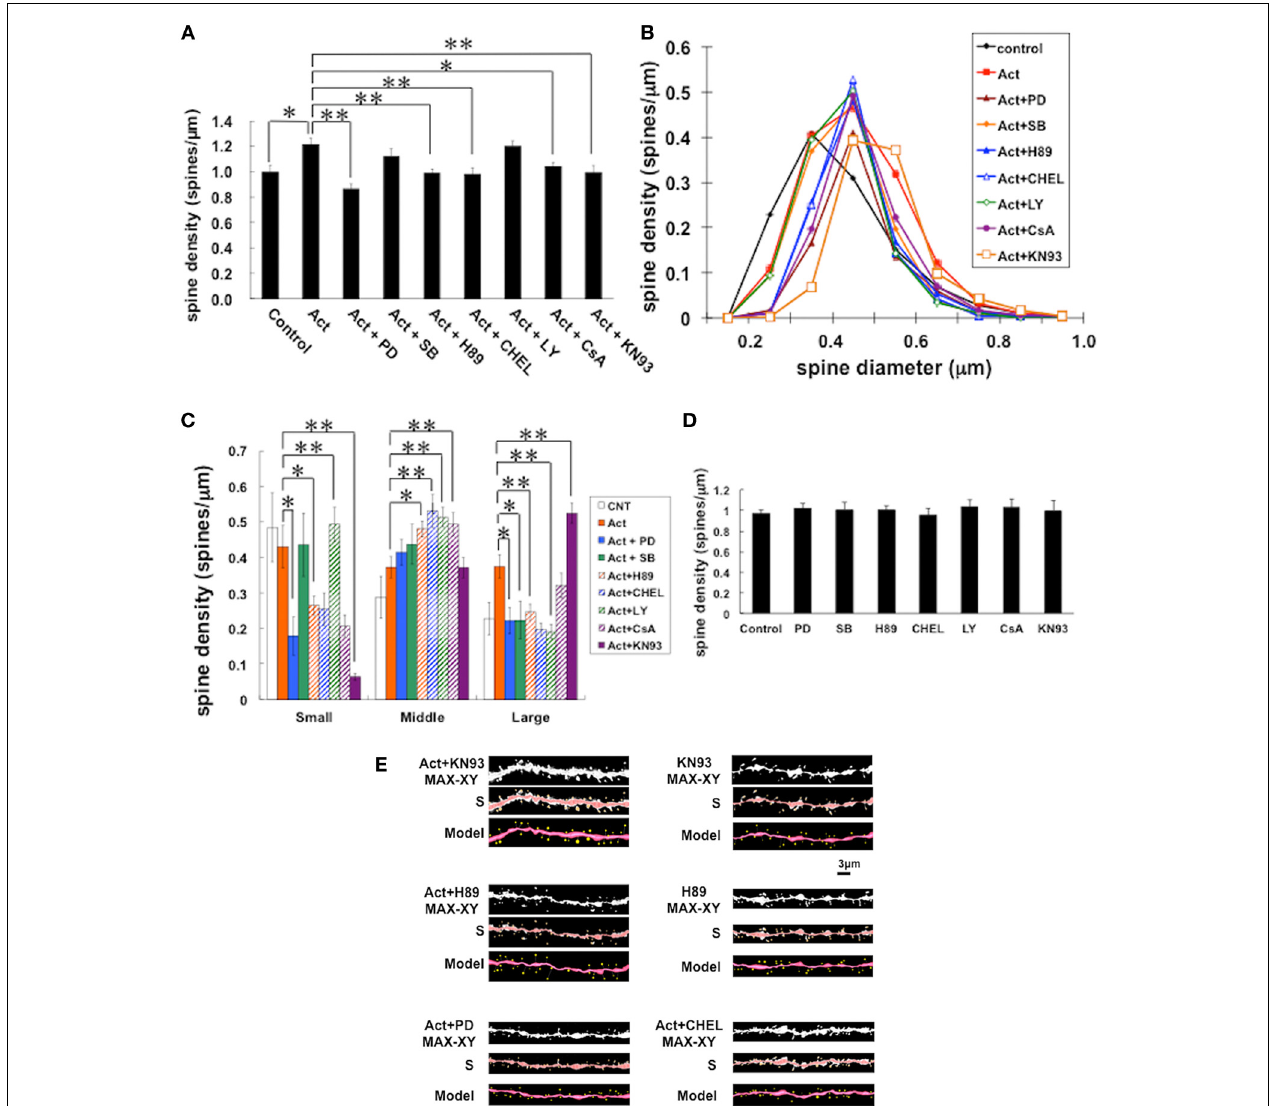
FIGURE 4 | Effects by inhibition of kinases on changes of the density and morphology of spines in the presence of activin A. Spines were analyzed along the secondary dendrites of CA1 pyramidal neurons. (A) Total spine density. Effect of kinase inhibitors in the presence of activin in CA1 neurons. Vertical axis is the average number of spines per 1 μ m. A 2-h treatment in ACSF without drugs (Control), with 10ng/mL activin (Act), with 10ng/mL activin and 20 μ M PD98059 (Erk MAPK inhibitor) (Act + PD), with 10ng/mL activin and 10 μ M SB203580 (p38 MAPK inhibitor) (Act + SB), with 10ng/mL activin and 10 μ M H-89 (PKA inhibitor) (Act + H89), with 10ng/mL activin and 10 μ M chelerythrine (PKC inhibitor) (Act + CHEL), with 10ng/mL activin A and 10 μ M LY294002 (PI3K inhibitor) (Act + LY), with 10ng/mL activin and 1 μ M cyclosporin A (calcineurin inhibitor) (Act + CsA), and with 10ng/mL activin and 1 μ M KN-93 (CaMKII inhibitor) (Act + KN93). Statistical significance is calculated against activin treated group and indicated by stars. ∗ P < 0 . 05, ∗∗ P < 0 . 01. (B) Histogram of spine head diameters. Abbreviations are the same as in (A) . Vertical axis is the number of spines per 1 μ m of dendrite. After a 2-h treatment in ACSF without drugs (Control, closed black diamond), Act (closed red square), Act + PD (closed brown triangle), Act + SB (closed orange diamond), with Act + H89 (closed blue triangle), with Act + CHEL (open blue triangle), with Act + LY (open green diamond), and Act + CsA (closed purple circle), and Act + KN93 (open orange square). (C) Density of three subtypes